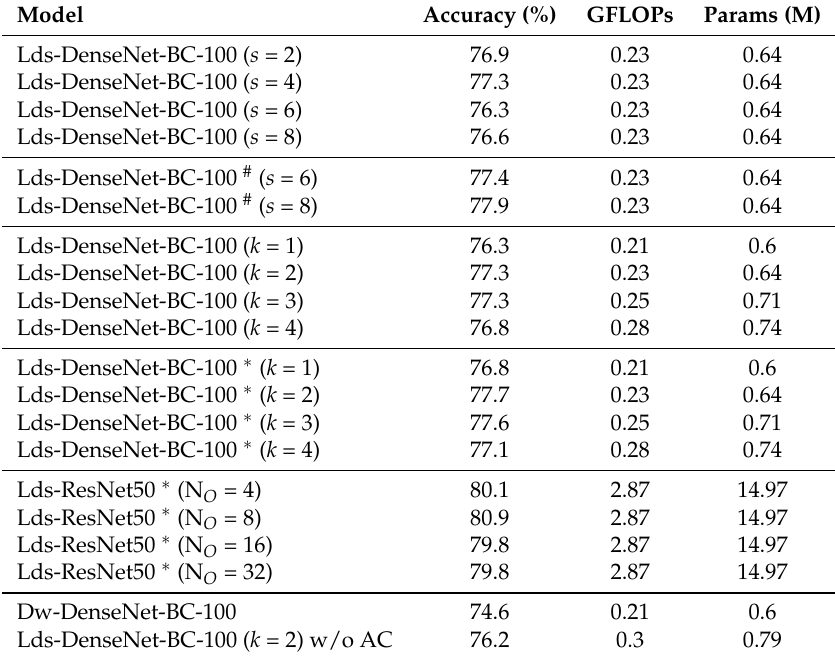
Table 1. The table shows the ablation study results in different setups on CIFAR-100. ‘ ∗ ’ refers to